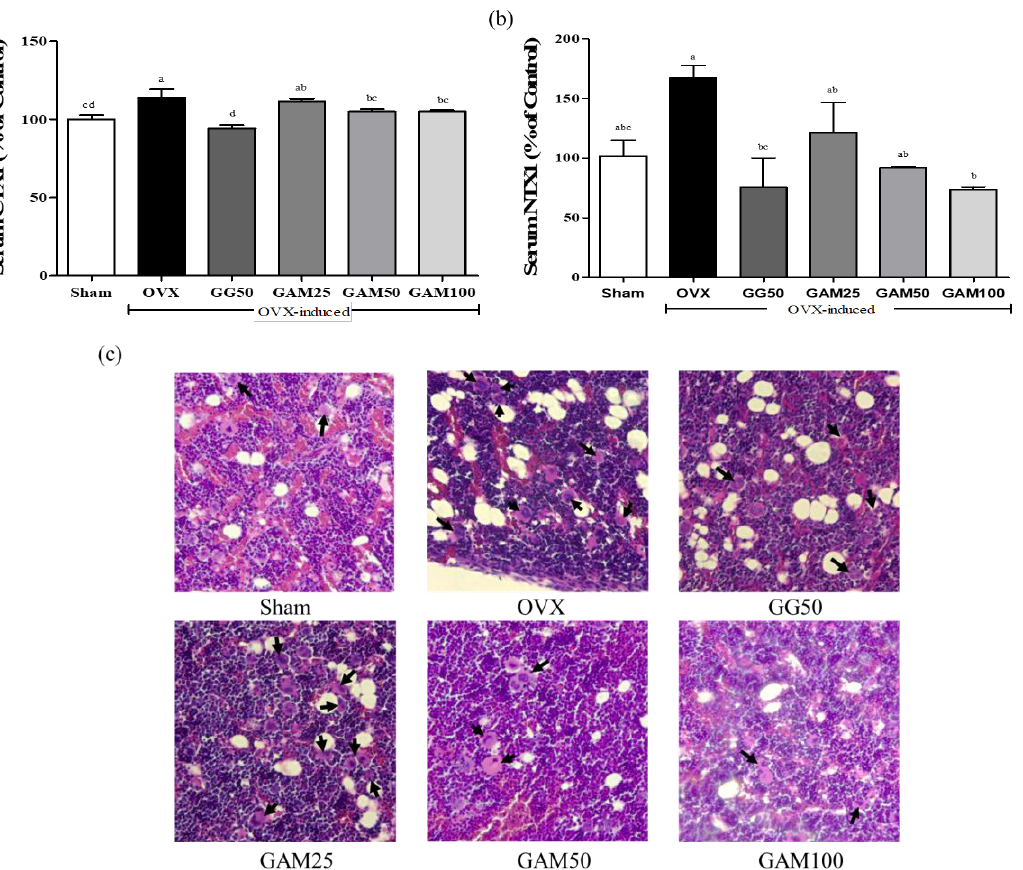
Figure 6. Effects of GAM on bone resorption biomarkers in OVX-induced rat models. The effects of GAM on ( a ) CTX1 and ( b ) NTX1 were evaluated using ELISA assay kits. ( c ) Rats were euthanized after 4 weeks of GAM treatment, and their femurs were dissected, fixed, decalcified, and sectioned. The sections were stained with H&E and visualized using a light microscope (×400). Osteoclasts are tagged with “Black arrow”. a–d Mean values with different letters differed significantly ( p < 0.05) among groups, as shown by Tukey’s test.